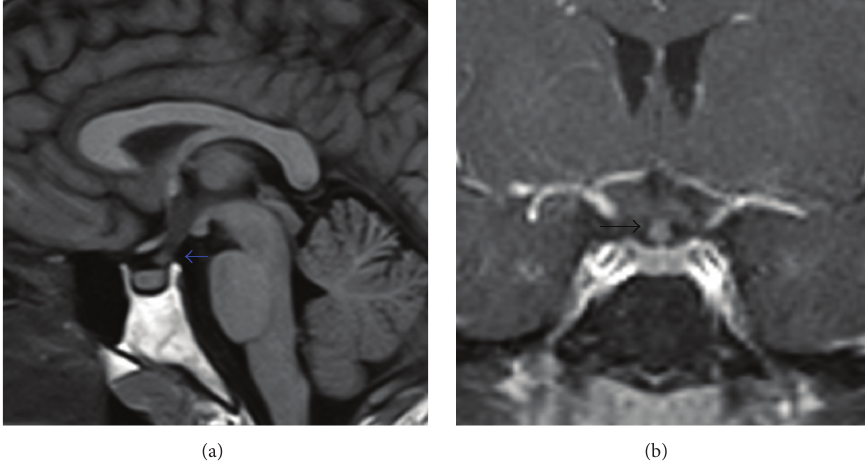
Figure 3: (a) Sagittal T1-weighted MRI of the sella turcica showing a thick pituitary stalk (arrow). Please note the absence of expected hyperintense (bright) signal of the neurohypophysis. (b) Coronal T1-weighted post-Gd MRI showing a thick pituitary stalk